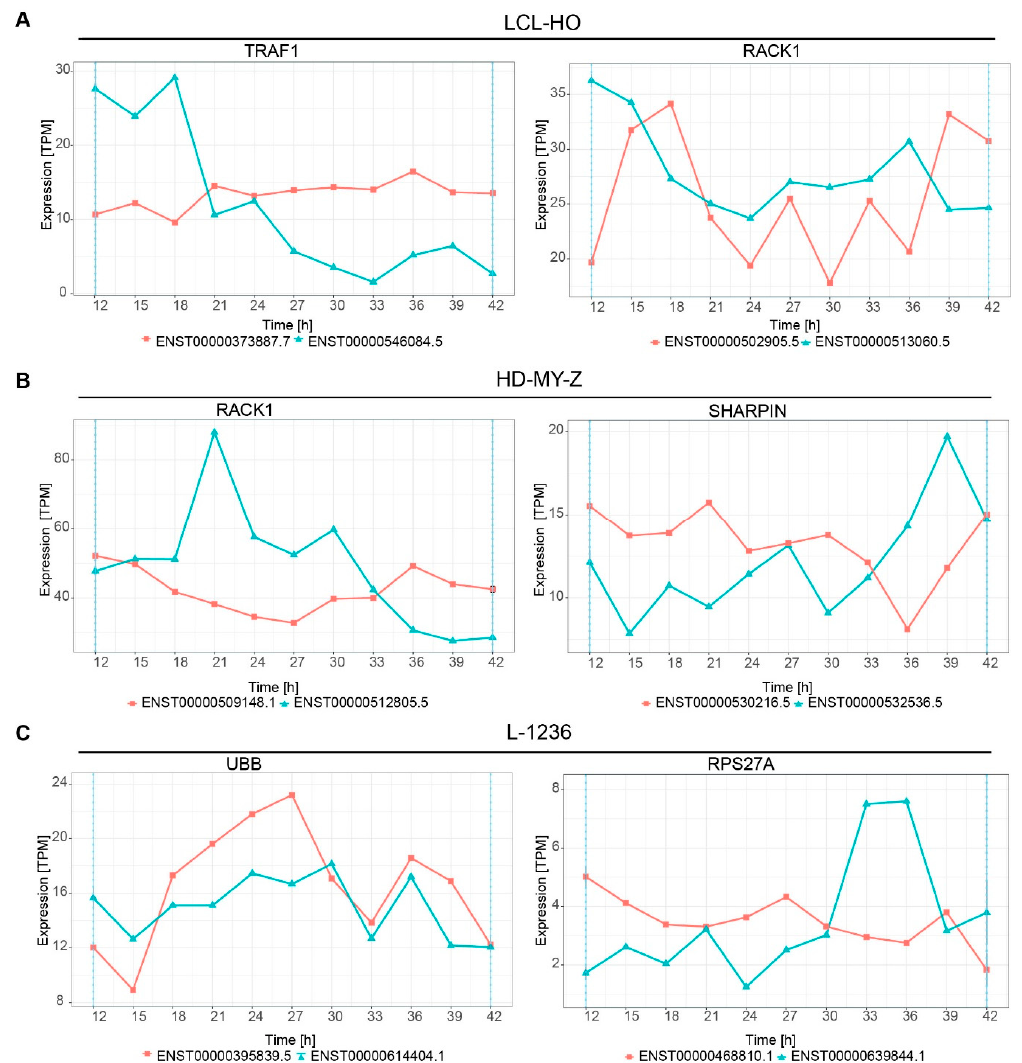
Figure 5. Multiple genes from the TNF pathway show switching between the isoform expression